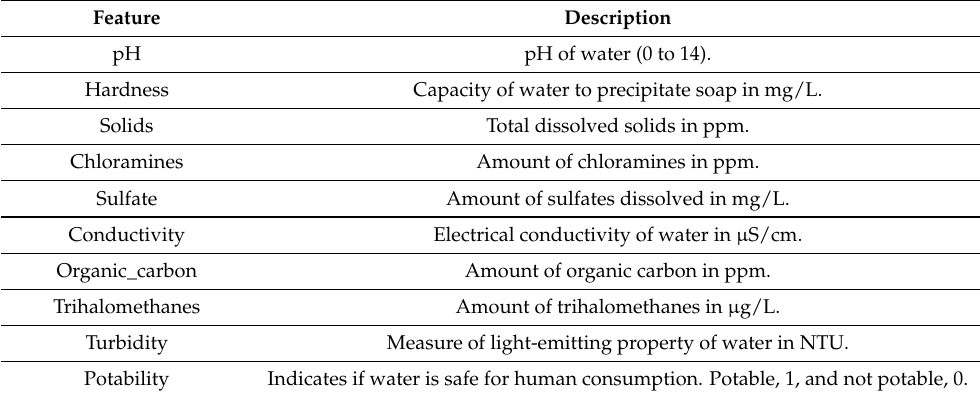
Table 2. Description of the dataset used in this